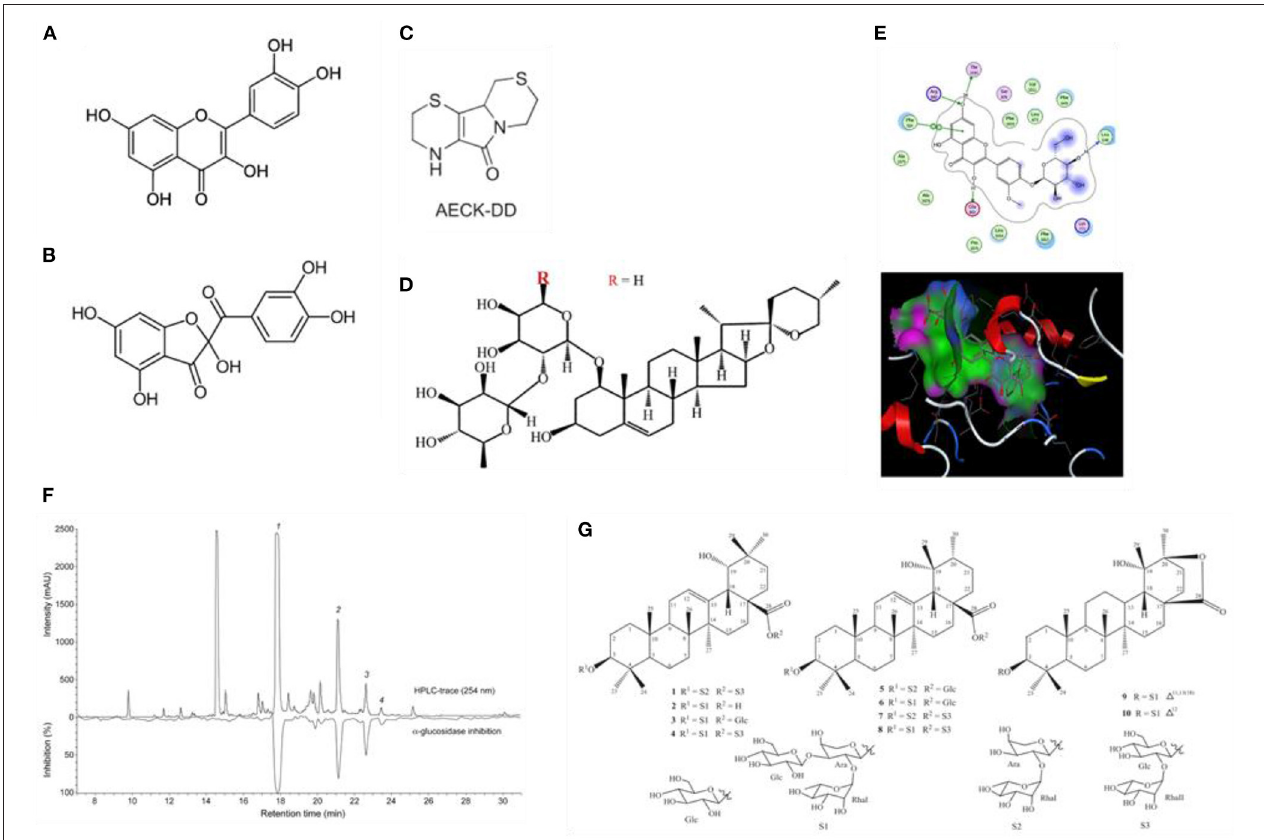
FIGURE 3 | Chemical structure of (A) quercetin (3,5,7,3 ′ ,4 ′ -pentahydroxyflavone); (B) the quercetin-derived benzofuranone [2-(3,4-dihydroxybenzoyl)-2,4,6-tri-hydr oxy-3(2 H )-benzofuranone]. (C) Aminoethyl cysteine ketimine decarboxylated dimer (AECK–DD); (D) Cepa2; (E) binding mode of isorhamnetin-3-glucoside with xanthine oxidase. (F) High-resolution α -glucosidase inhibition profile of the ethyl acetate extract of the peel of A. ascalonicum with overlaid HPLC chromatogram at 254nm. Peaks numbered 1 – 4 (corresponding to compounds 1 – 4 ) correlated with α -glucosidase inhibition and were analyzed by HPLC-HRMS-SPE-NMR. (G) Chemical structures of compounds 1–10 isolated from shallot screened for anoctamin inhibitory capacity. Compounds 2 and 9 exerted the highest anoctamin inhibitory potential (